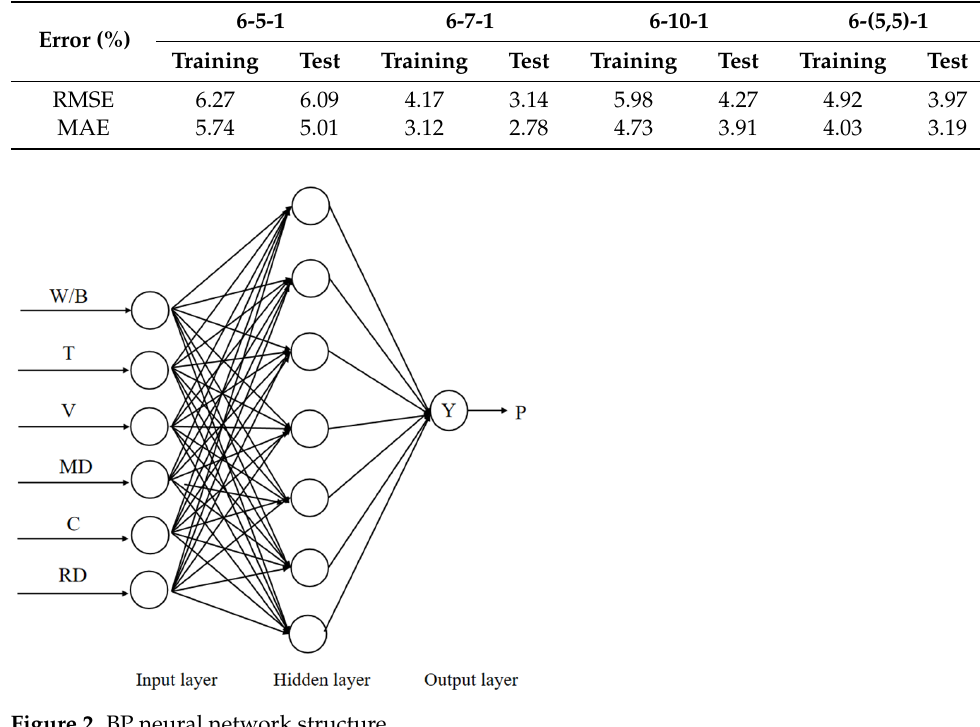
Figure 2. BP neural network structure.